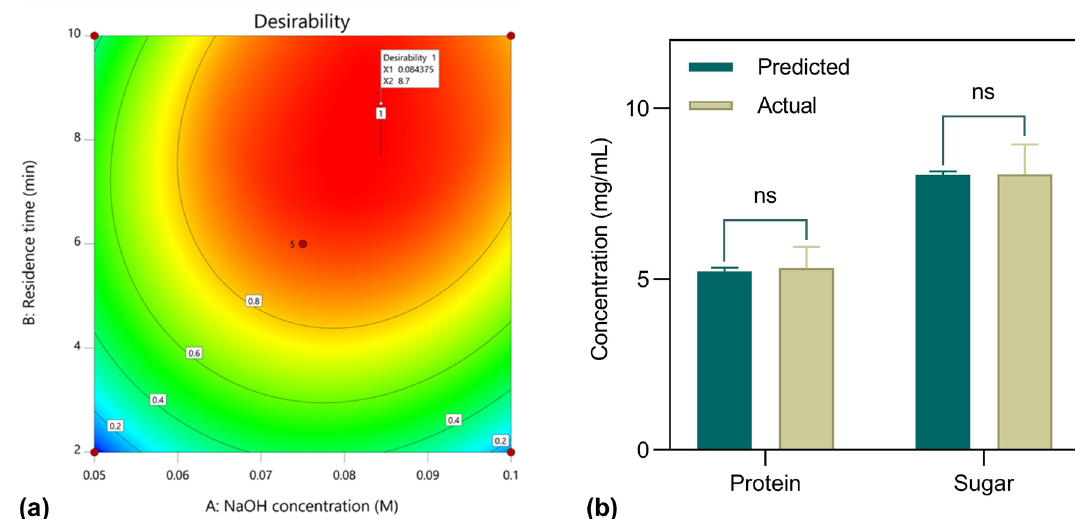
Figure 2. Validation of the quadratic optimization model: contour plot of quadratic model desirability prediction ( a ); experimental runs of MAH of DSM-JP cocktail based on the predicted optimum parameters ( b ). Data presented are the means ± standard deviations from three independent experiments (Student’s t -test: * P < 0.05; ** P < 0.01; ns P > 0.05). The graphs were visualized in DOE software (v 11; Stat-Ease, Inc., MN, USA; www. state ase. com) and GraphPad PRISM software (v 8.02; GraphPad, Inc., MN, USA; www. graph pad. com).